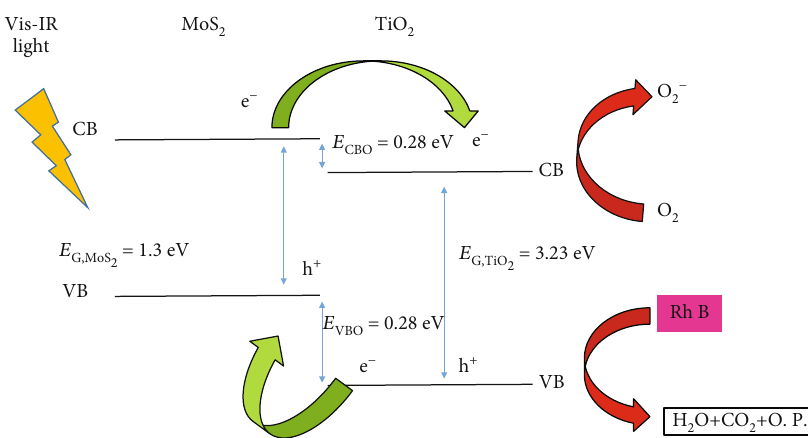
Figure 10: Schematic illustration of charge transfer of TiO